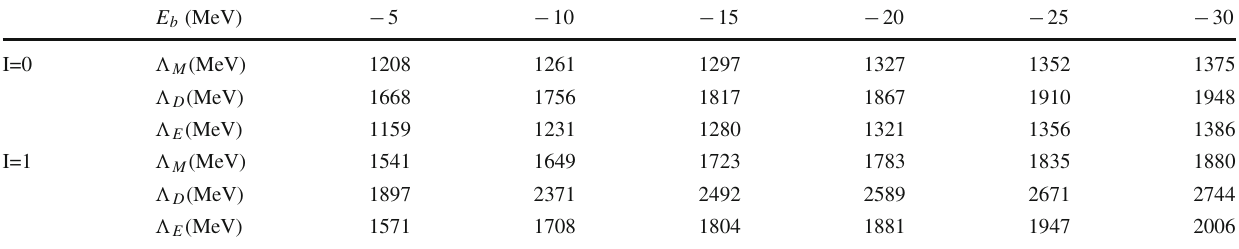
Table 1 Values of E b and corresponding cutoff (cid:18) M , (cid:18) D , and (cid:18) E for I = 0 and I = 1 ¯ D 1 K bound states for the monopole, dipole, and exponential form factors, respectively